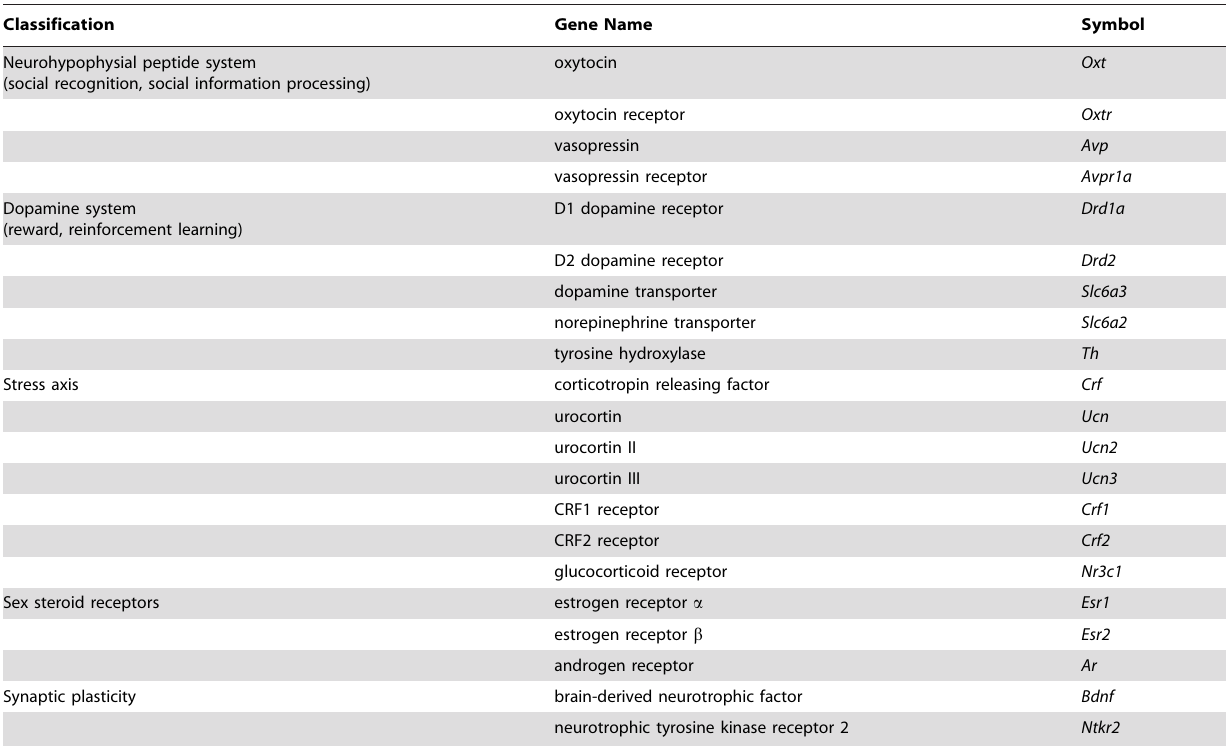
Table 1. List of 21 behaviorally-relevant